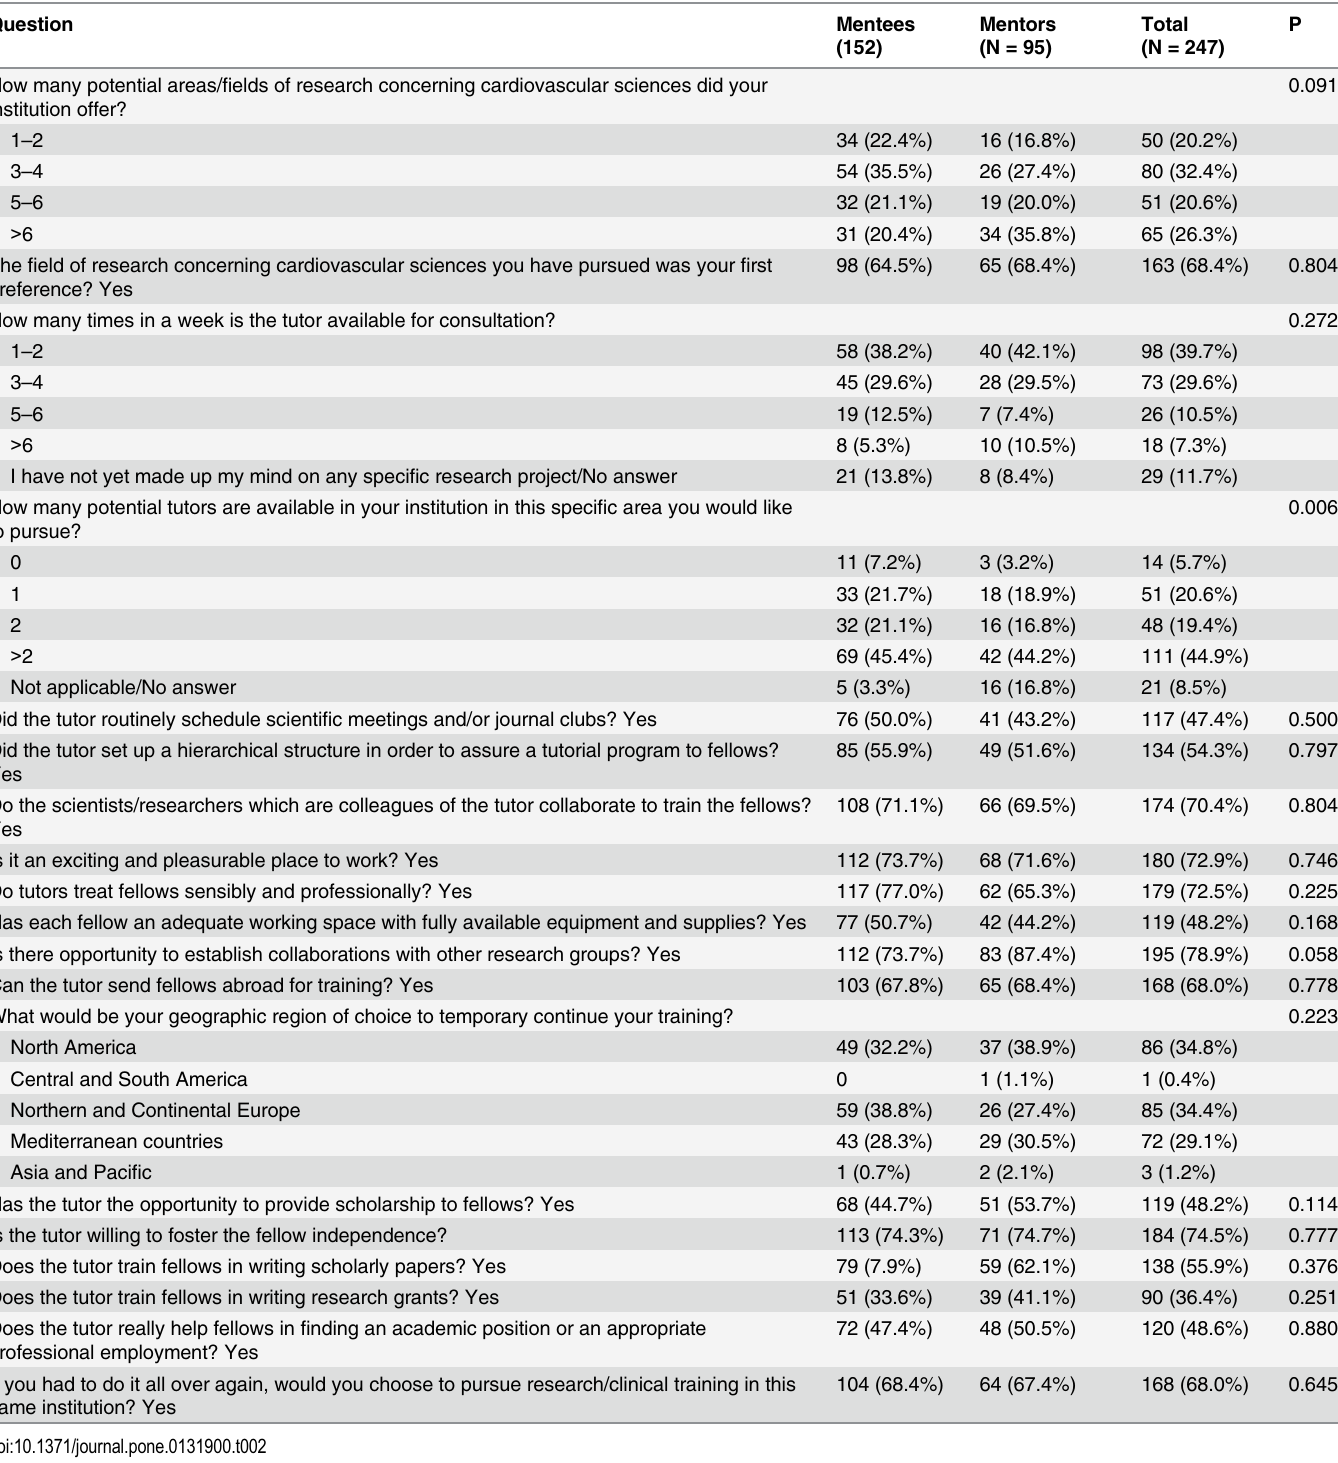
Table 2. Survey results: overall and distinguishing mentees and